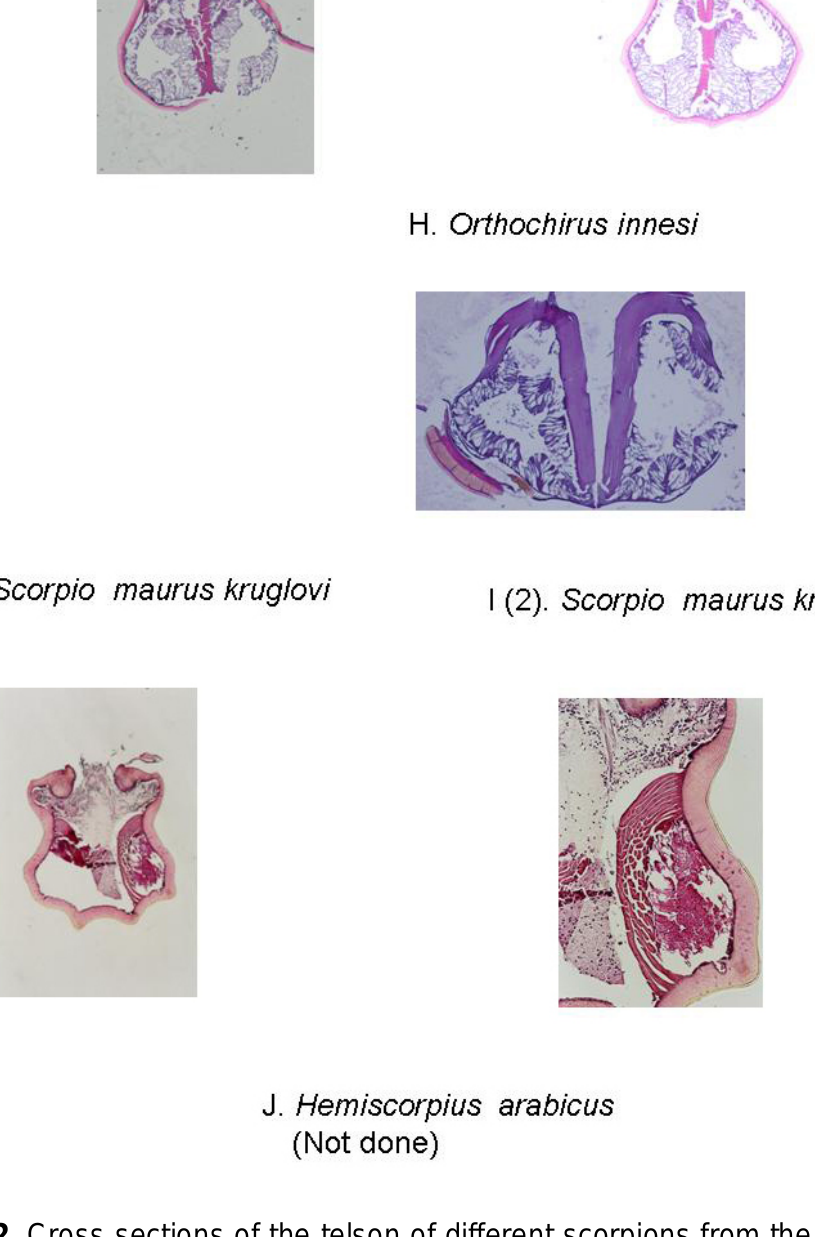
Figure 12. Cross sections of the telson of different scorpions from the Riyadh region showing the paired venom glands. Individuals of the families Buthidae, Scorpionidae and Hemiscorpiidae (not shown). ( A ) Compsobuthus arabicus ; ( B )